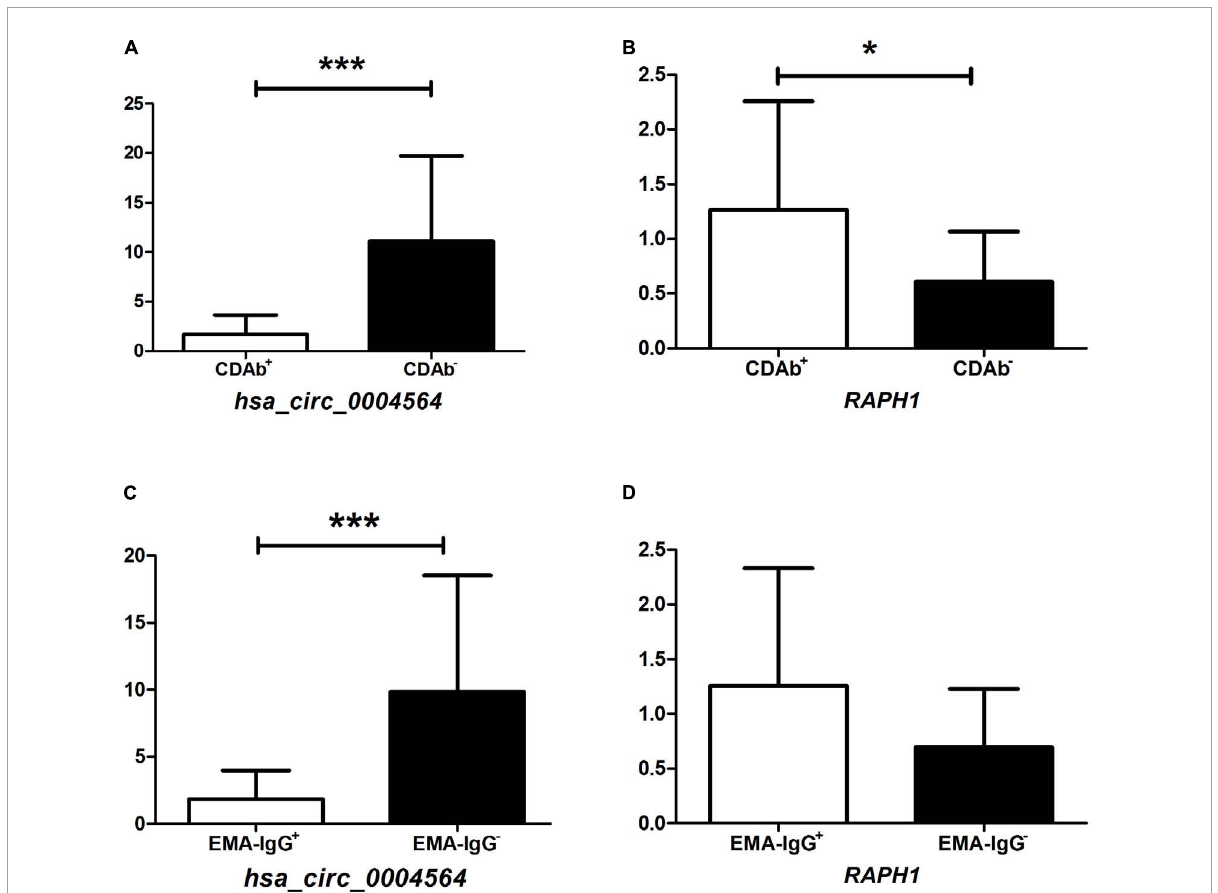
FIGURE4 Association of hsa_circ_0004564 and RAPH1 in children with T1D with CDAb positivity. ( ∗ p < 0.05, ∗∗ p < 0.01, ∗∗∗ p < 0.001). Vertical lines indicate one standard deviation above and below the mean. Student’s t -test. (A) hsa_circ_0004564 with CDAbs. (B) RAPH1 with CDAbs. (C) hsa_circ_0004564 with EMA-IgG. (D) RAPH1 with EMA-IgG. CDAbs, celiac disease autoantibodies; T1D, type 1 diabetes; EMA, endomysial antibody; Ig,